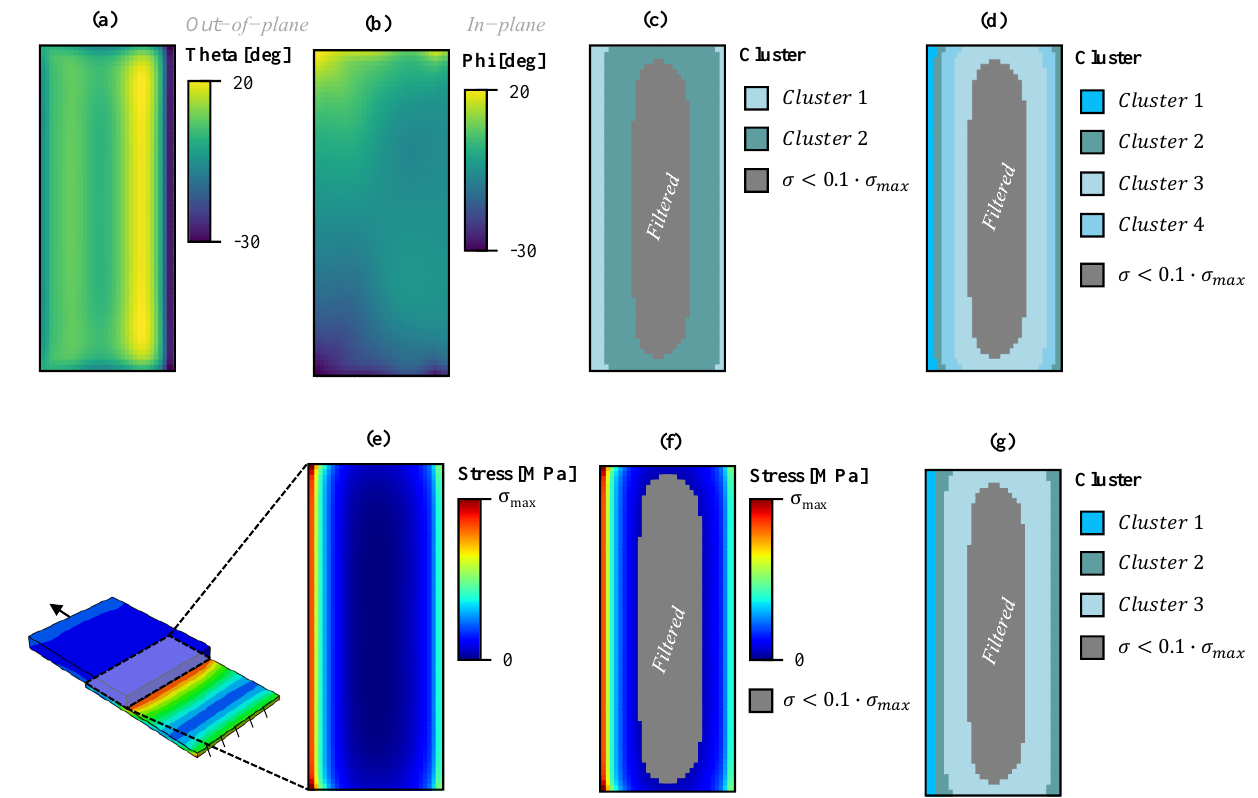
Figure 10. Resulting concepts for the demonstration example. In ( a ) and ( b ) the theta and phi angles are shown. In ( e ) the von Mises distribution is shown. ( f ) shows the application of the stressThreshold for a value of 0.1. In ( c , d , g ) the use of two, three and four clusters are shown.